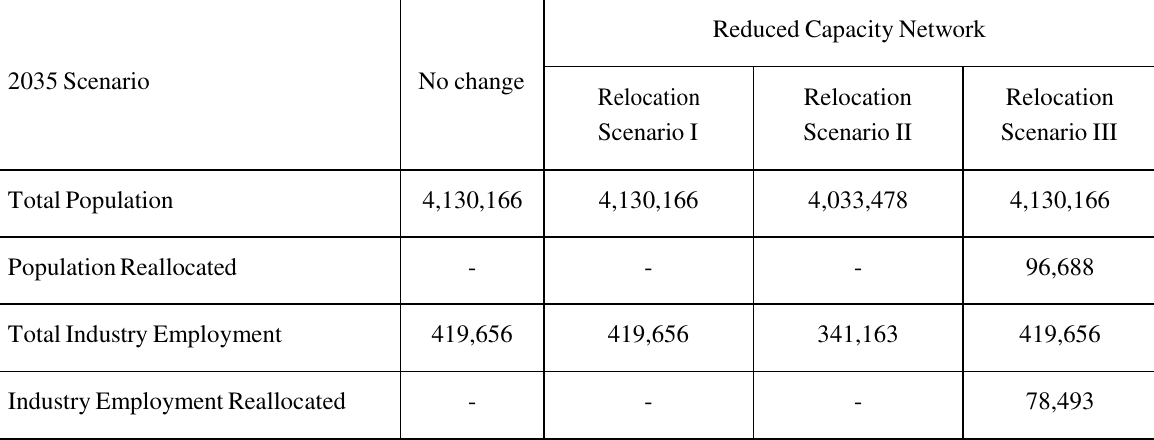
Table 1 Summary of the model results for the affected population and employment under the relocation scenarios